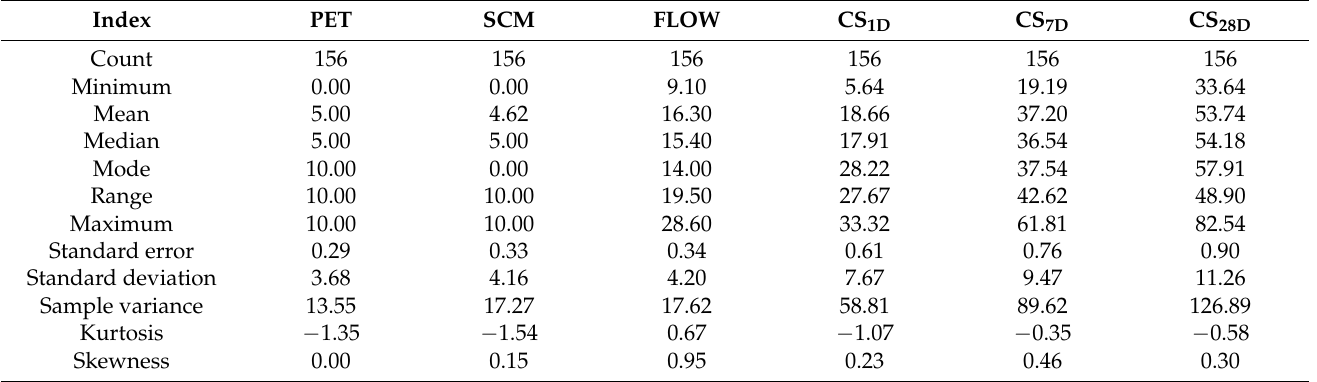
Table 1. Description details of the main dataset.